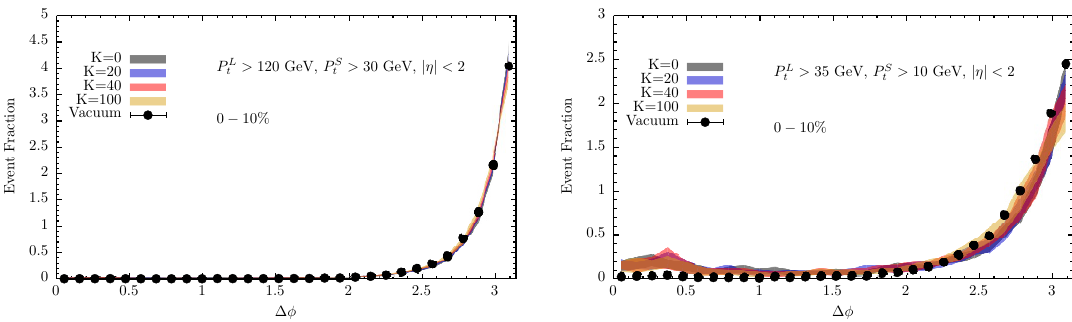
Figure 3 . Dijet acoplanarity distribution for high-energy (left) and low-energy (right) dijets in LHC heavy ion collisions with p s = 2 : 76 ATeV for two di(cid:11)erent values of the broadening parameter K . For comparison, the black dots show the acoplanarity in proton-proton collisions as simulated by Pythia